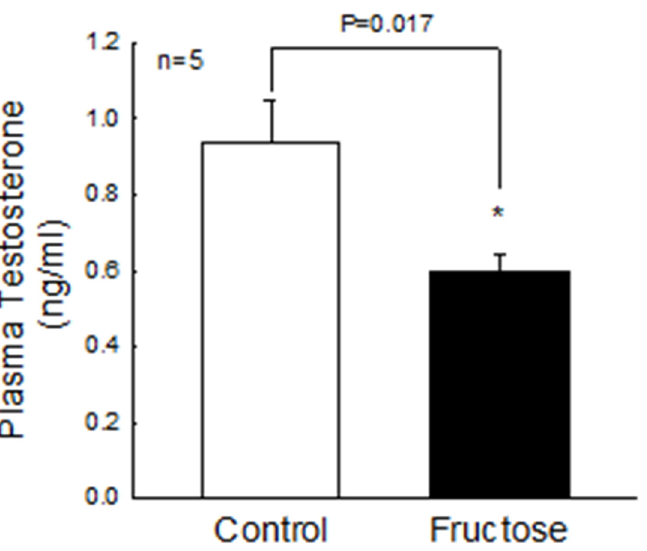
Figure 1. Effects of the fructose-fed diet on plasma testosterone levels. Plasma testosterone levels in the control and fructose-fed group. * p < 0.05 as compared to the control group. Each value presents mean ± SEM. Similar results were repeated twice.